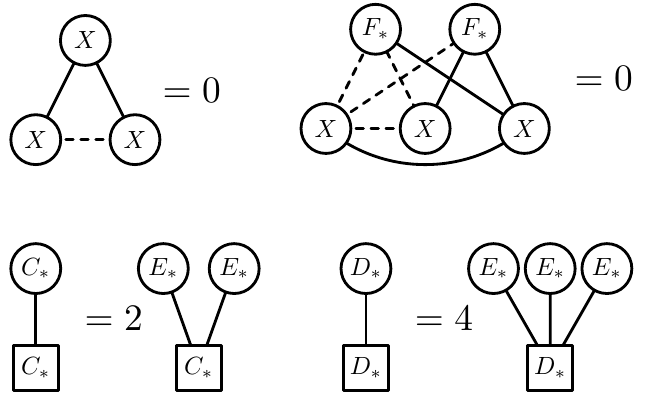
Figure 13: The decorated constraints forcing the tiles C ∗ × C ∗ and D ∗ × D ∗ . The constraints on the first line should hold for X = C ∗ and X = D ∗ .